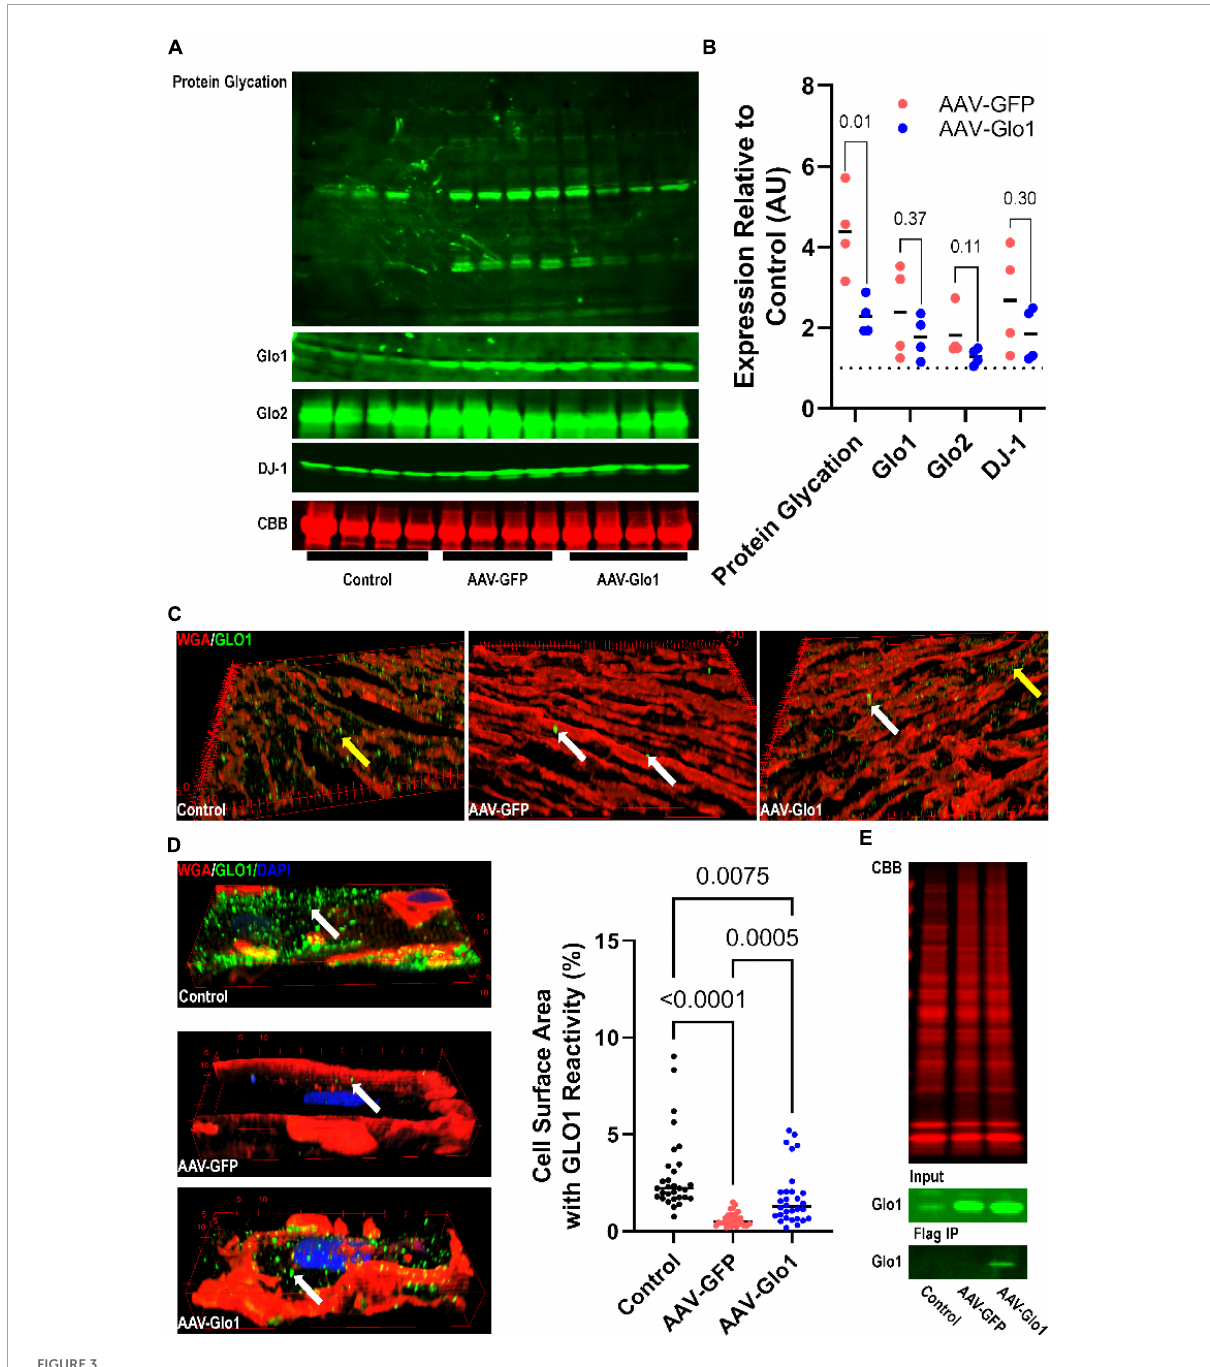
FIGURE3 AAV9-mediated GLO1 overexpression reduced protein glycation in the RV of MCT rats. (A) Representative Western blot images of protein glycation, GLO1, GLO2, and DJ-1 in RV tissue extracts. Post transfer SDS-PAGE gels were stained with CBB. (B) Quantification of Western blot protein expression of protein glycation, GLO1, GLO2, and DJ-1 in the RV. p -values determined by unpaired t -test because control animals were used as the normalizing standard of 1. (C) Three-dimensional reconstructions of RV sections stained with GLO1 antibody. Yellow areas highlight intramyocardial GLO1 staining. AAV-GFP rats had small areas of intense GLO1 immunoreactivity outside of cardiomyocytes (white arrows) and reduced cardiomyocyte GLO1 staining. AAV-Glo1 animals also had punctate staining of high GLO1 reactivity (white arrows), but intramyocardial staining was also increased (yellow arrow). (D) Representative three-dimensional projections of confocal micrographs of RV cardiomyocytes showing GLO1 localization. AAV-GFP RV cardiomyocytes had reduced intracellular GLO1 levels, but AAV-Glo1 treatment partially restored cardiomyocyte GLO1 levels. p -values determined by Kruskal-Wallis test with Dunn’s multiple comparison test. (E) CBB stained SDS-PAGE of input RV extracts for FLAG immunoprecipitation (top). Western blot of GLO1 in input (middle) and FLAG immunoprecipitation elution fraction (bottom) demonstrating FLAG-tagged GLO1 was only detected in AAV-Glo1